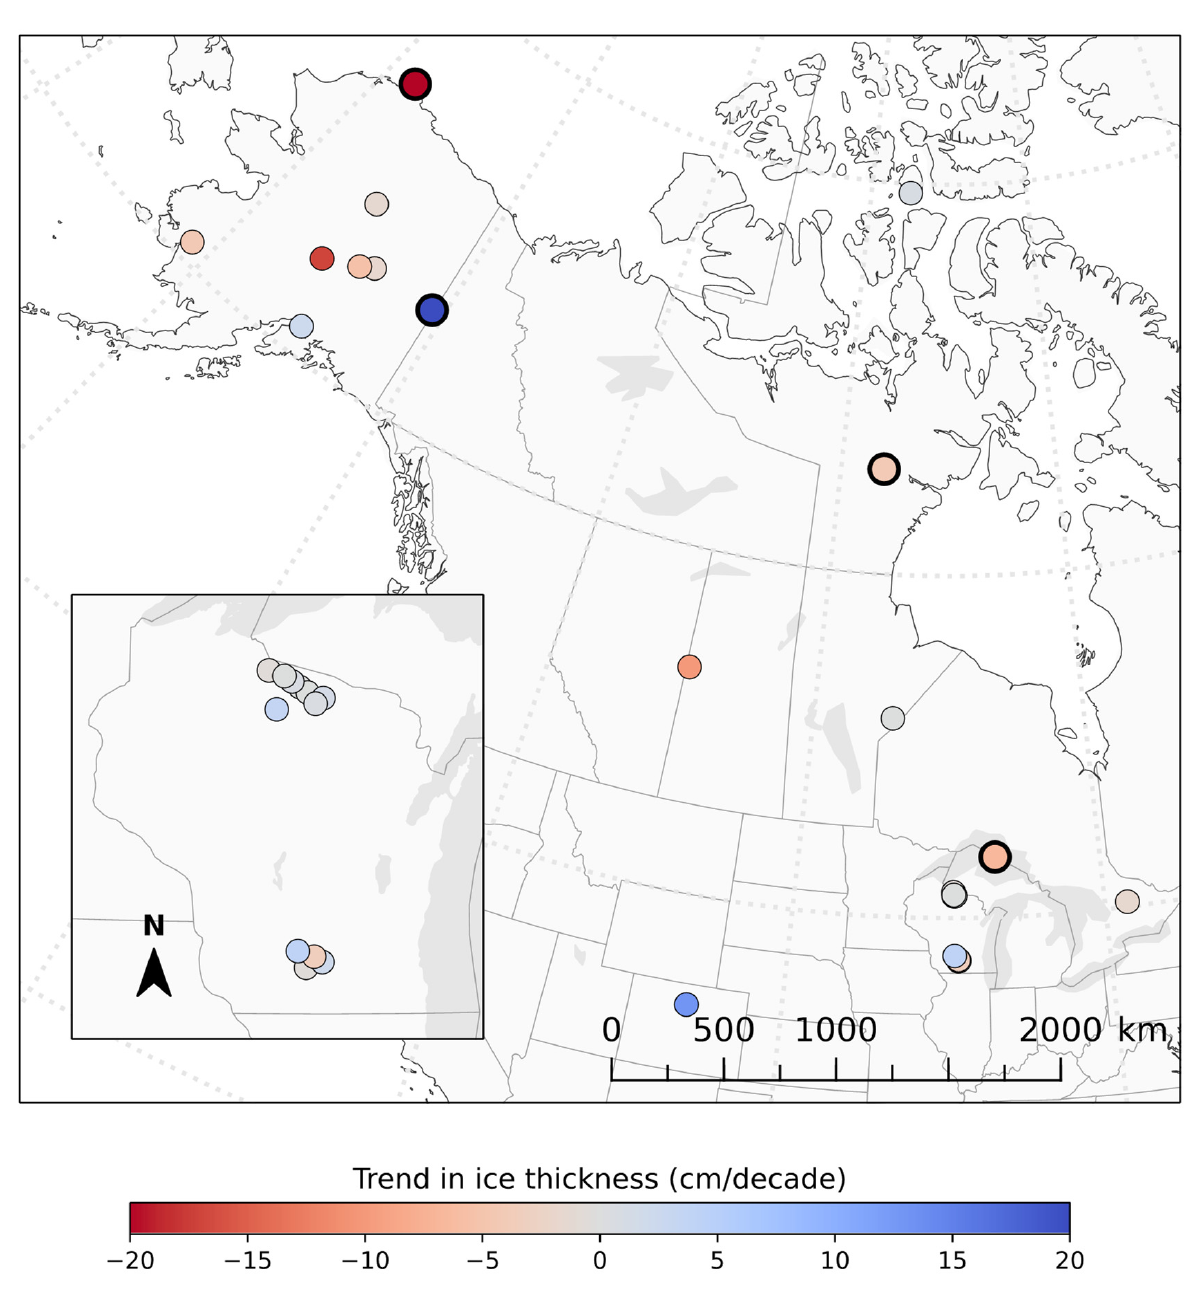
Figure 1. Trends in ice thickness (cm/decade) for lakes and rivers across North America. Spearman correlations for drivers affecting maximum ice thickness (cm) of lakes. Decreasing trends in ice thickness are represented by warmer colors and increasing trends in ice thickness are represented by cooler colors.